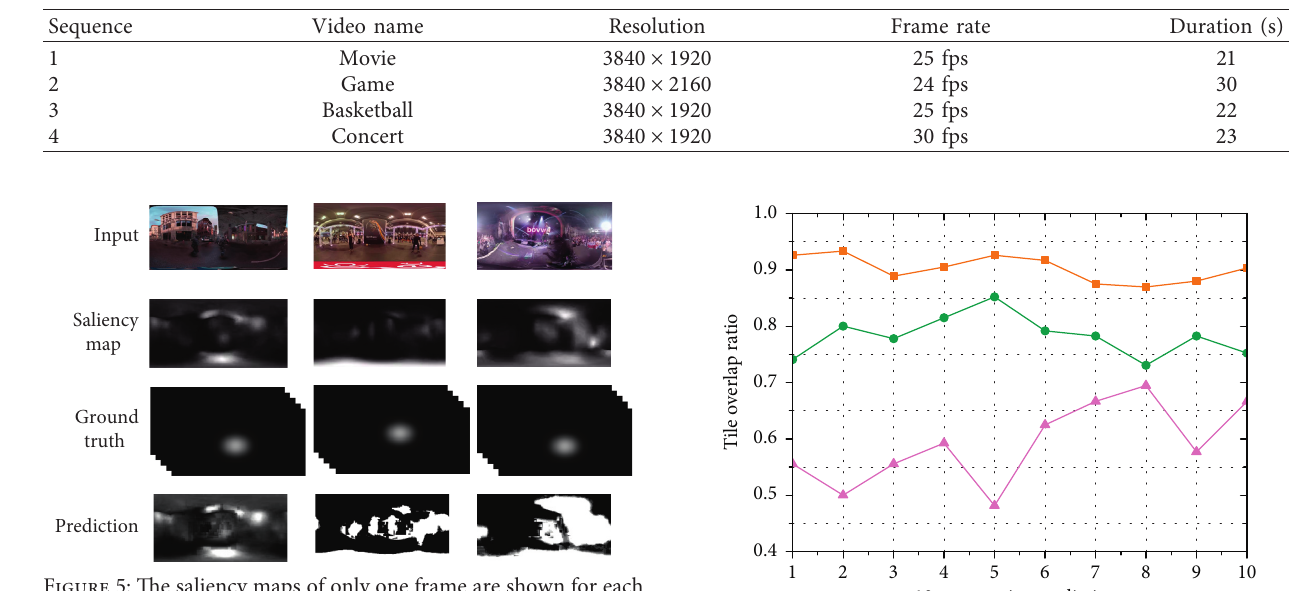
Table 1: Parameters of the four original videos used in the experiments.